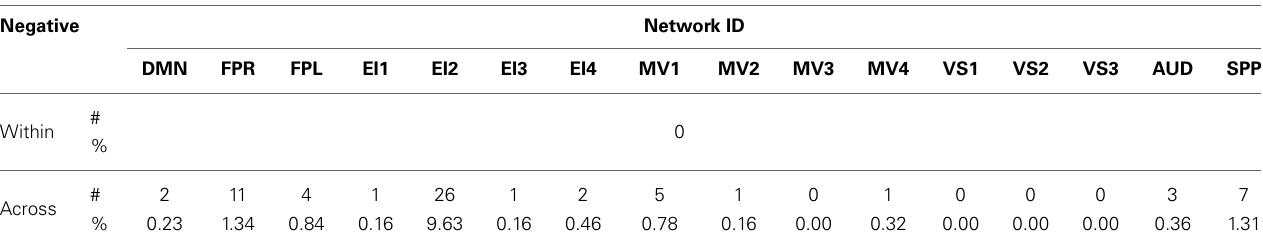
Table 5 | Absolute (#) and relative (%) number of connections with negative CVAR for each network. Negative Network